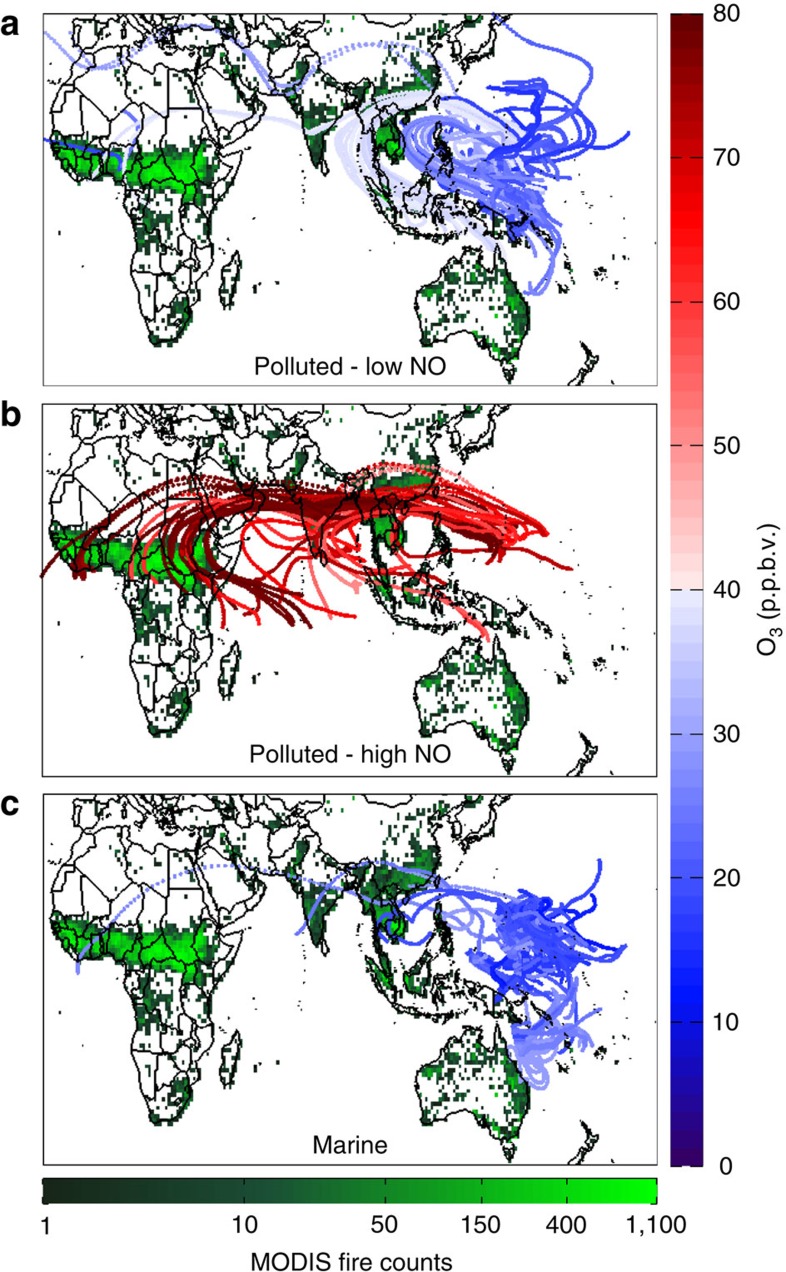
Back trajectories by chemical regime.10-day, HYSPLIT back trajectories for all CAST flights analysed here and CONTRAST RF03–05 and RF07–14 for observed pressures between 300 and 700 hPa. Trajectories are stopped when encountering convective precipitation and coloured by observed O3. Trajectories are separated by the CO regimes illustrated in Supplementary Fig. 2: (a) Polluted—low NO (CO >95 p.p.b.v. and NO <40 p.p.t.v.), (b) Polluted—high NO (CO >95 p.p.b.v. and NO >50 p.p.t.v.), and (c) Marine (CO <80 p.p.b.v. and NO <30 p.p.t.v.). The sum of January and February 2014 MODIS fire counts is shown in green.